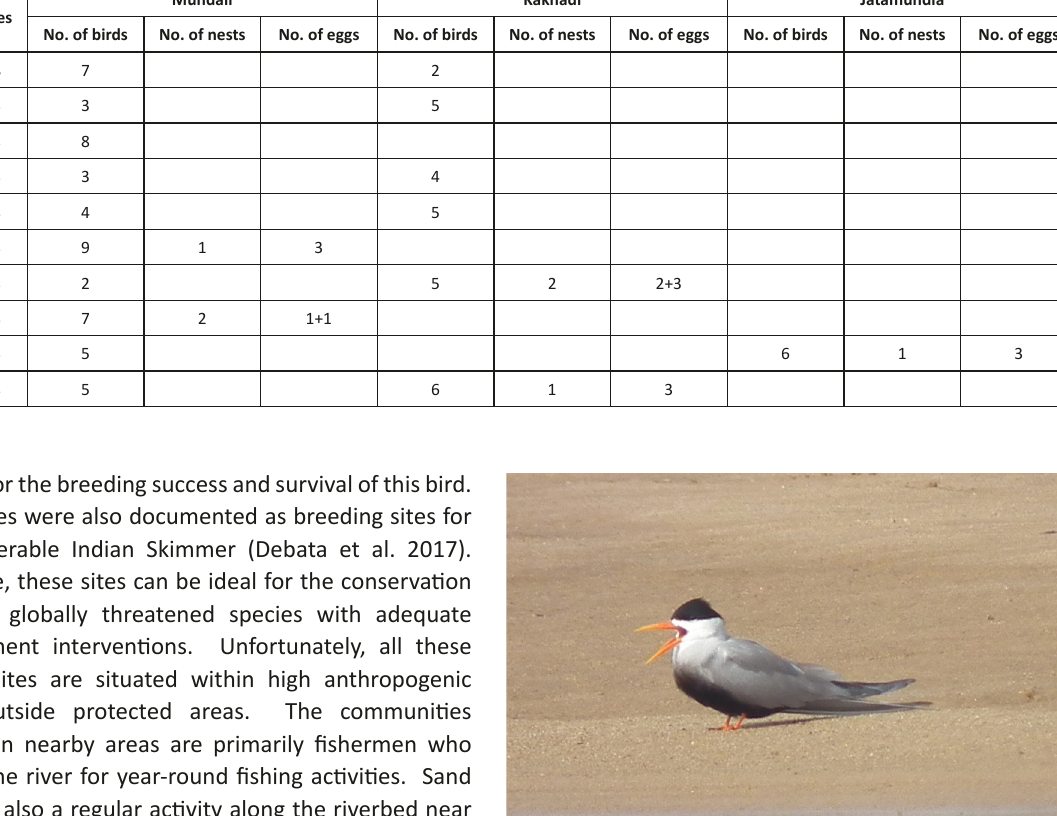
Table 1. Number of individual Black-bellied Terns, nests, and eggs recorded during 5–27 February 2018 from different localities along the Mahanadi River in Odisha, eastern India Survey dates